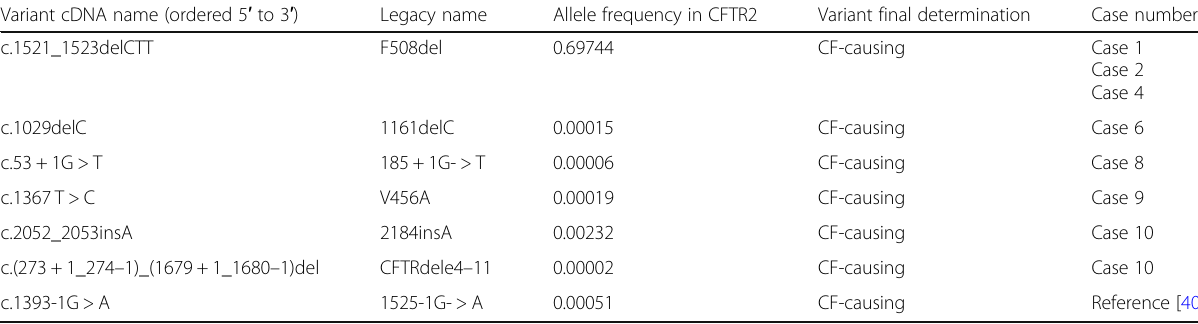
Table 2 Characteristics of CF-causing genetic variants detected in Sri Lankan patients, annotated by CFTR2 Variant cDNA name (ordered 5 ′ to 3 ′